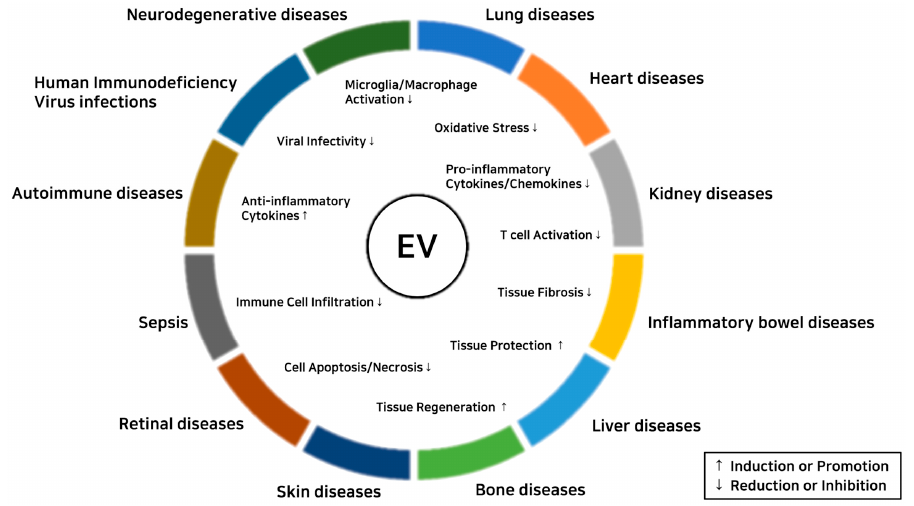
Figure 3. Therapeutic effects of extracellular vesicles (EV) on inflammatory diseases.